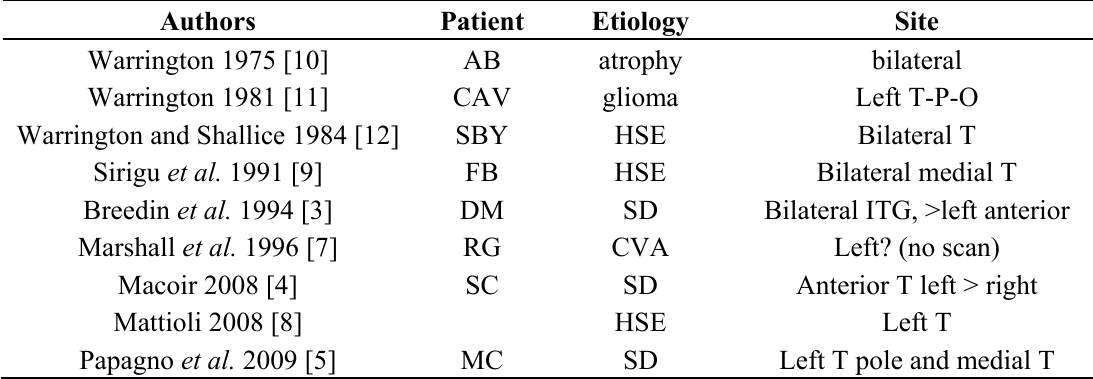
Table 1. Neuropsychological single cases with a reversed concreteness effect. Legend: HSE = herpes simplex encephalitis; SD = semantic dementia; CVA = cerebrovascular accident; T = temporal; P = parietal; O = occipital; ITG = inferior temporal